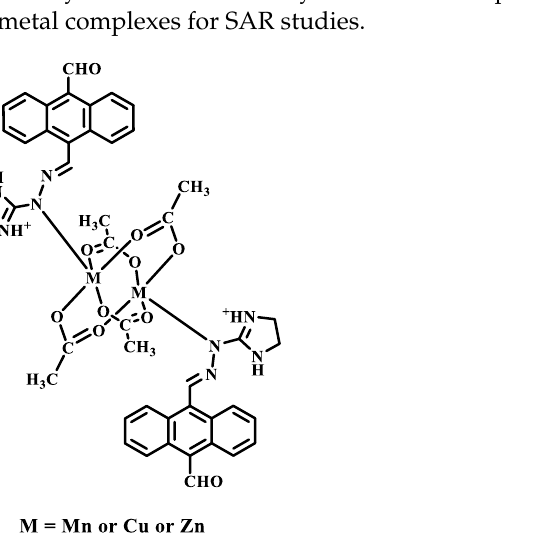
Figure 45. Binuclear transition metal complexes of p -aldehyde anthrahydrazone with the same im- idazoline side chain as bisantrene with bridging coordinated by four acetate co-ligands. 3.2.2. The Second and Third Transition Metal Complexes of Anthrahydrazone with Anti- cancer Activities As early as 2009, Floyd A. Beckford et al. [70,127,128] designed and synthesized a series of 9-anthrachydrazones with N -substituted thiourea as side chains and used them as the active ligands to coordinate with Ru(II) through N / S -bidentate chelation. Benzene and p - cymene were used as Π -bonding co-ligands. Four corresponding organometallic Ru(II) complexes were synthesized and characterized, and their structures are shown in Figure 46. The anticancer activities of these Ru(II) complexes against several human can- cer cell lines were compared via an in vitro test. The results showed that the N -substituent group had an obvious effect on the anticancer activity of Ru(II) complexes: CH 3 > H > C 6 H 5 > C 2 H 5 [70,127]. In addition to the metal complex with a N -ethyl thiourea side chain, the MDA-MB-231 cell line was the most sensitive to the other three Ru(II) complexes (IC 50 = 2~9 μM), while cisplatin only had inhibitory activity of 730 μM. Thus, the Ru(II) complexes of anthrahydrazone retained the high cytotoxic selectivity of anthracyclines to breast can- cer cells. The N -ethyl-substituted complex showed weak and unsatisfactory inhibitory ac- tivity on colon cancer cells. After 72 h, the IC 50 values of two kinds of colon cancer cells, HCT-116 and Caco- 2, were only 200~225 μM, and there were no significant differences in their inhibitory effect on normal colon tissue cells. However, the complex showed a strong binding effect with HSA and DNA and could significantly inhibit the activity of Topo II, suggesting that it might be able to inhibit other different types of cancer cells. Then, an organometallic Ru(II) complex with benzene as the Π -bonding co-ligand was synthesized by a novel microwave-assisted synthesis method. The side chain group of anthrahydra- zone was thiourea or N -ethyl thiourea [128]. In previous studies, Ru(II) complexes with a N -ethyl thiourea side chain had the lowest activity, but the authors continued to select the Ru(II) complex replaced by N -ethyl, which may be related to its strong binding affinity with HSA/DNA and Topo II inhibition. The results showed that the aryl Ru(II) complexes of the two anthrahydrazones could bind with DNA and HSA intensively and inhibit the proliferation of the two colon cancer cells, HCT-116 and cacO-2. The activity of the N - ethyl-substituted Ru(II) complex was 1~2 times that of the non-substituted Ru(II) complex. Furthermore, the anticancer activity of the Ru(II) complex against both cancer cells was also higher than that of the Ru(II) complex with the same side chain but with the co-ligand p -cymene, suggesting that the corresponding Ru(II) complex might have higher in vitro